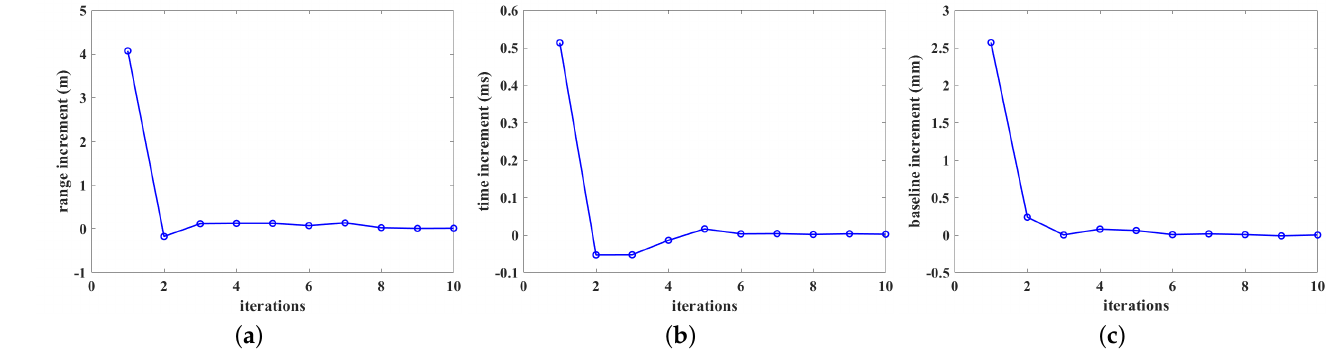
Figure 16. In the data experiment, the convergence curves of ( a ) slant range, ( b )timing parameters, ( c ) parallel baseline. The vertical axis are the module length, and the horizontal axis represents the number of